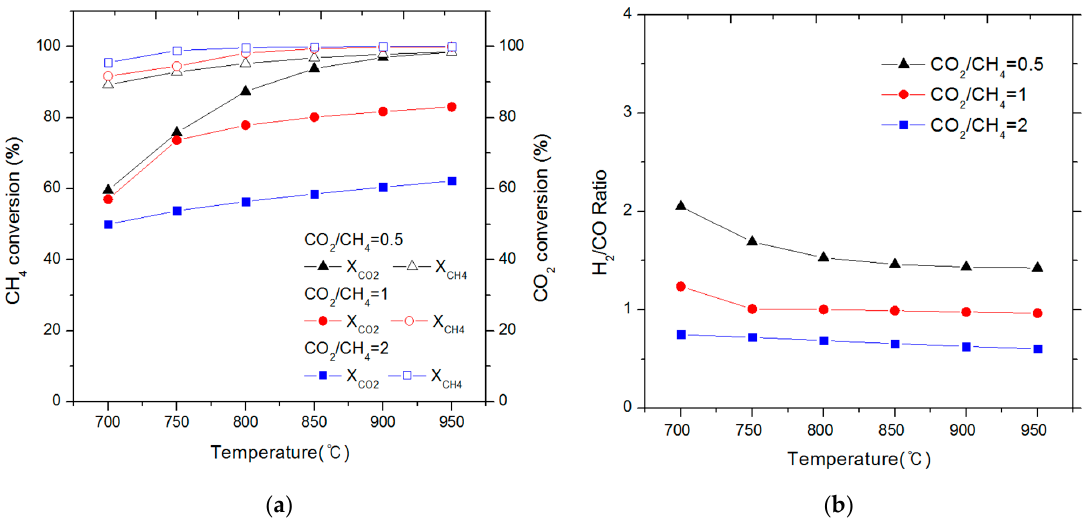
Figure 1. ( a ) E ff ects of CO 2 / CH 4 ratio on CO 2 and CH 4 conversion rates during a simulated biogas reforming reaction; ( b ) E ff ects of CO 2 / CH 4 ratio on H 2 / CO ratio during a simulated biogas reforming